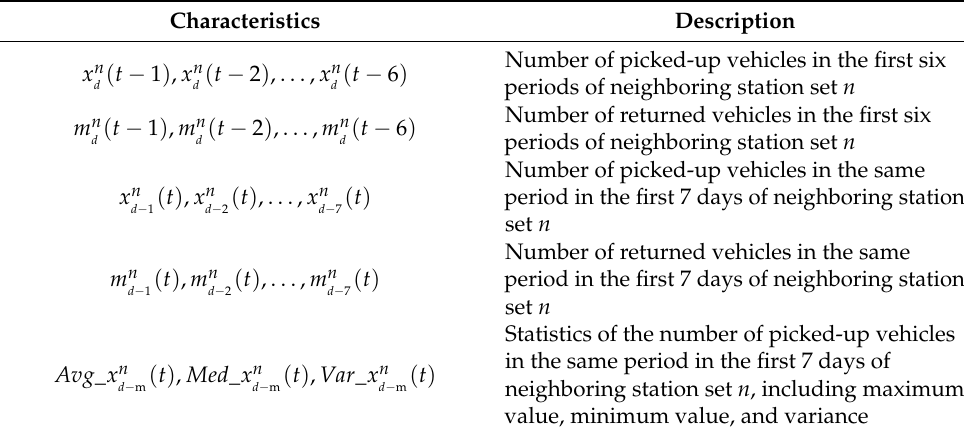
Table 5. Information characteristics of adjacent station